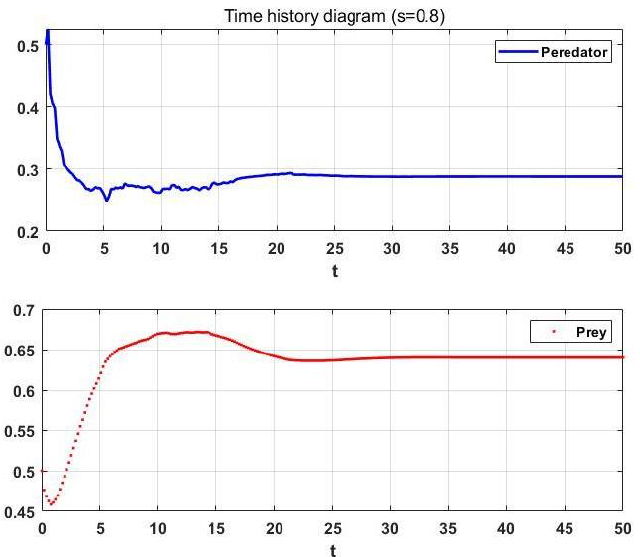
Figure 10. Time history diagram and phase diagram of the system when disturbed with σ 1 = 0, σ 2 =